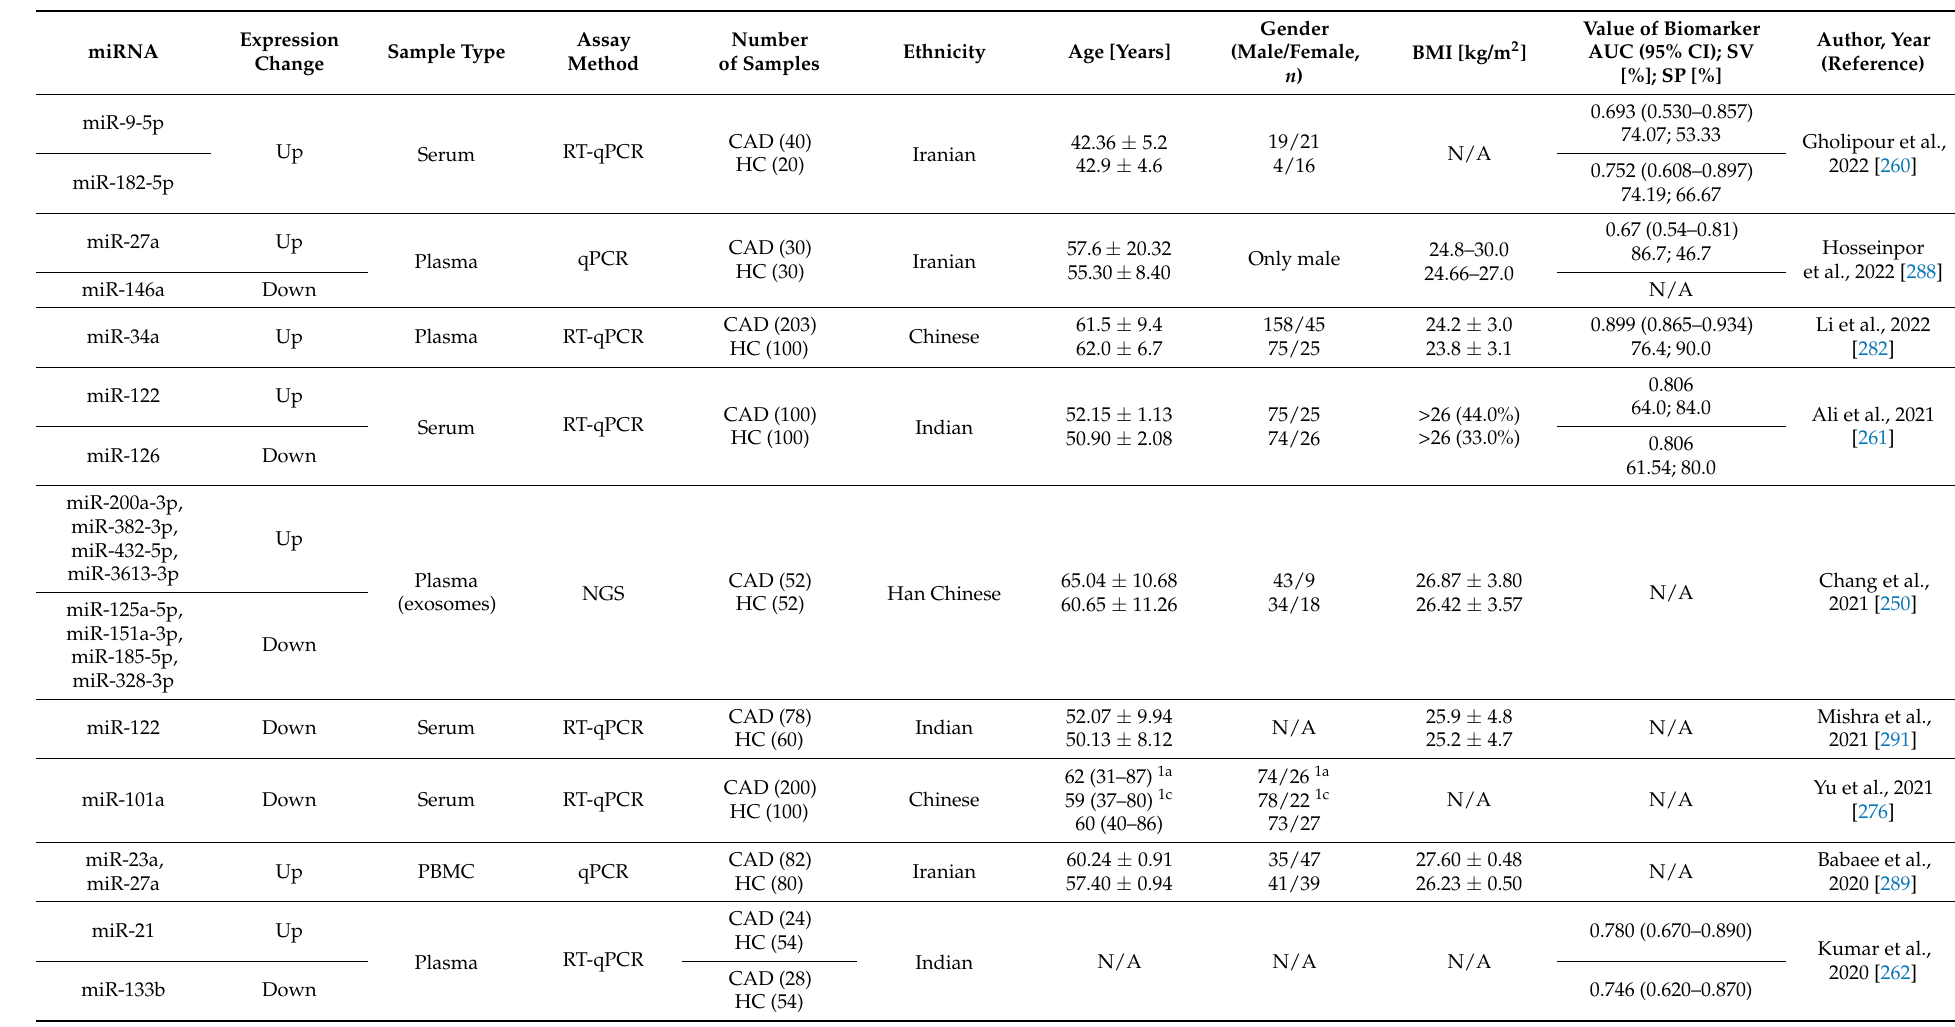
Table 2. Circulating microRNAs as potential biomarkers for stable coronary artery